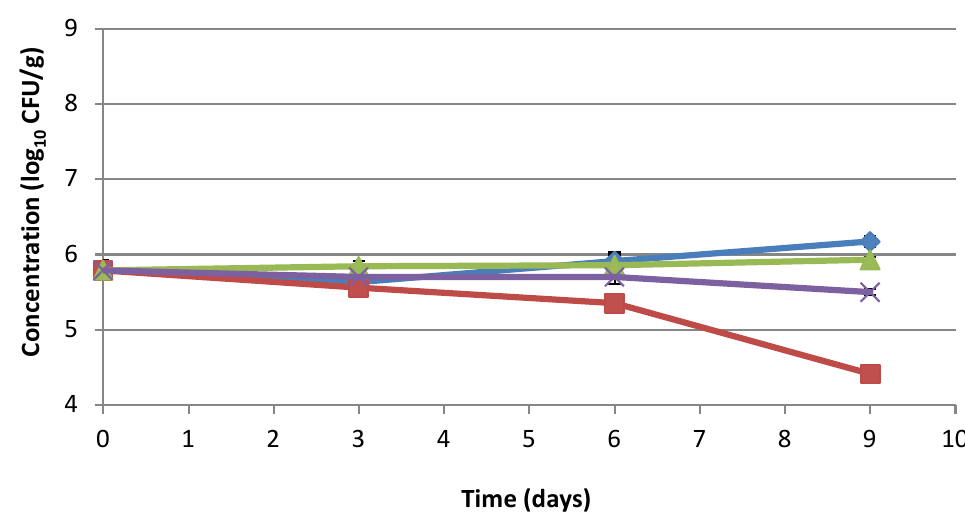
Figure 3. Effect of fermented tomato byproduct extract on L. monocytogenes in minced pork meat. Behavior of L. monocytogenes in minced pork meat with or without fermented tomato byproduct extract/preservatives determined through microbial challenge test. L. monocytogenes concentration in minced pork meat (blue line), minced pork meat with 1.6% fermented tomato byproduct extract (red line), minced pork meat with 1.2%sodium lactate (green line), and minced pork meat with 2.5% sodium lactate/sodium diacetate (96:4) (purple line). Concentration is expressed as log 10 CFU/g.